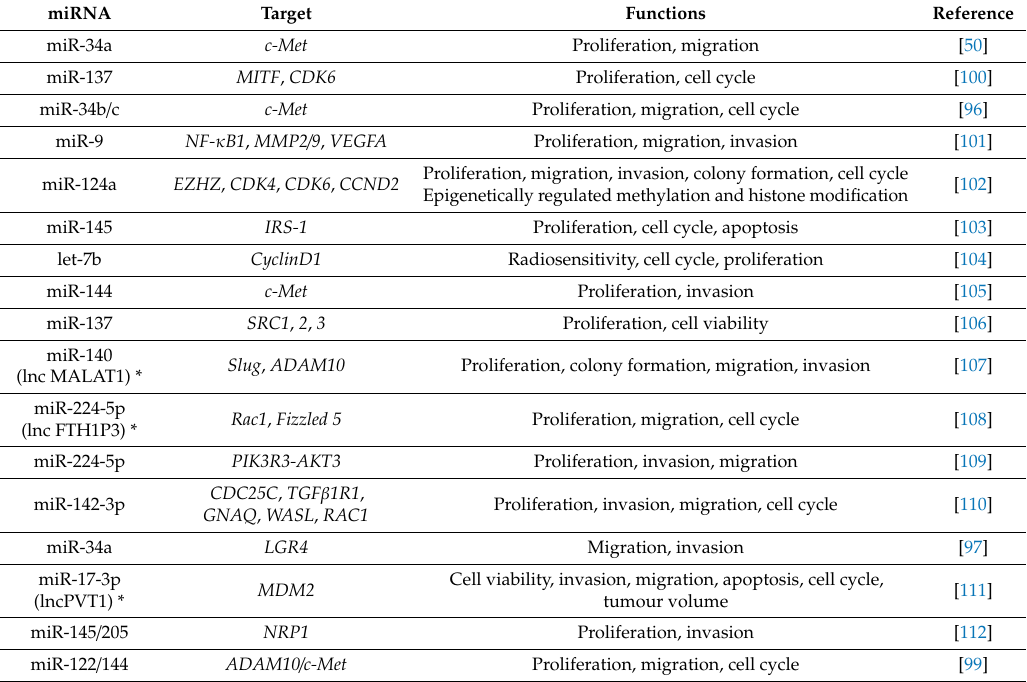
Table 2. Downregulated tumour suppressor miRNAs in